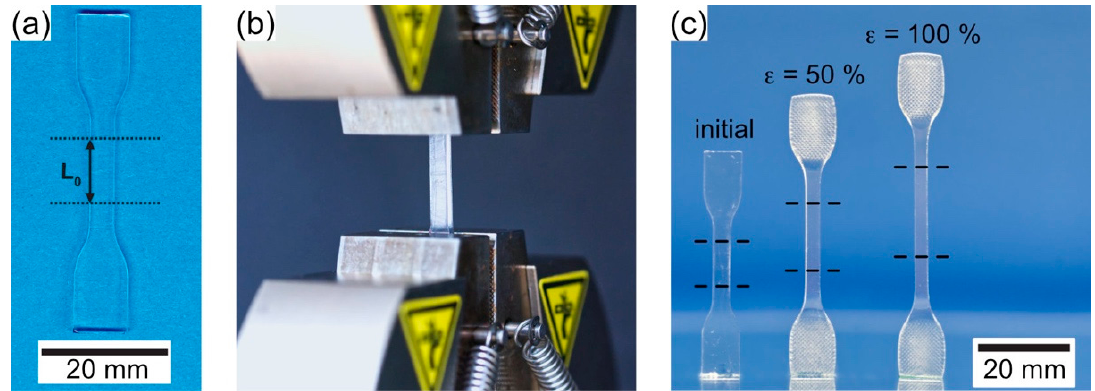
Figure 3. Specimen geometry and programming. ( a ) Dog-bone-type flat tensile specimen used in the present work. ( b ) Specimen mounted into test rig with heating chamber prior to processing. ( c ) As-processed specimen together with two specimens which were programmed imposing 50% and 100% programming strain.